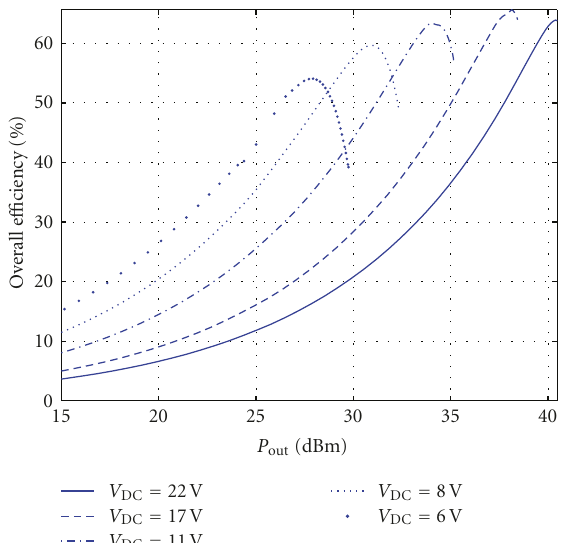
Figure 12: Illustration of overall e ffi ciency as a function of output power for di ff erent amplifier drive voltages V DC using the HPA in [42], where V DC = 22 V is the highest possible drive